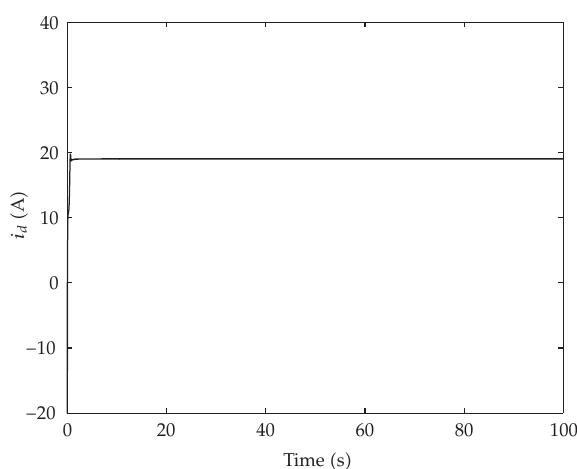
Figure 7: The i d curve of the chaotic PMSM drive system with u d .